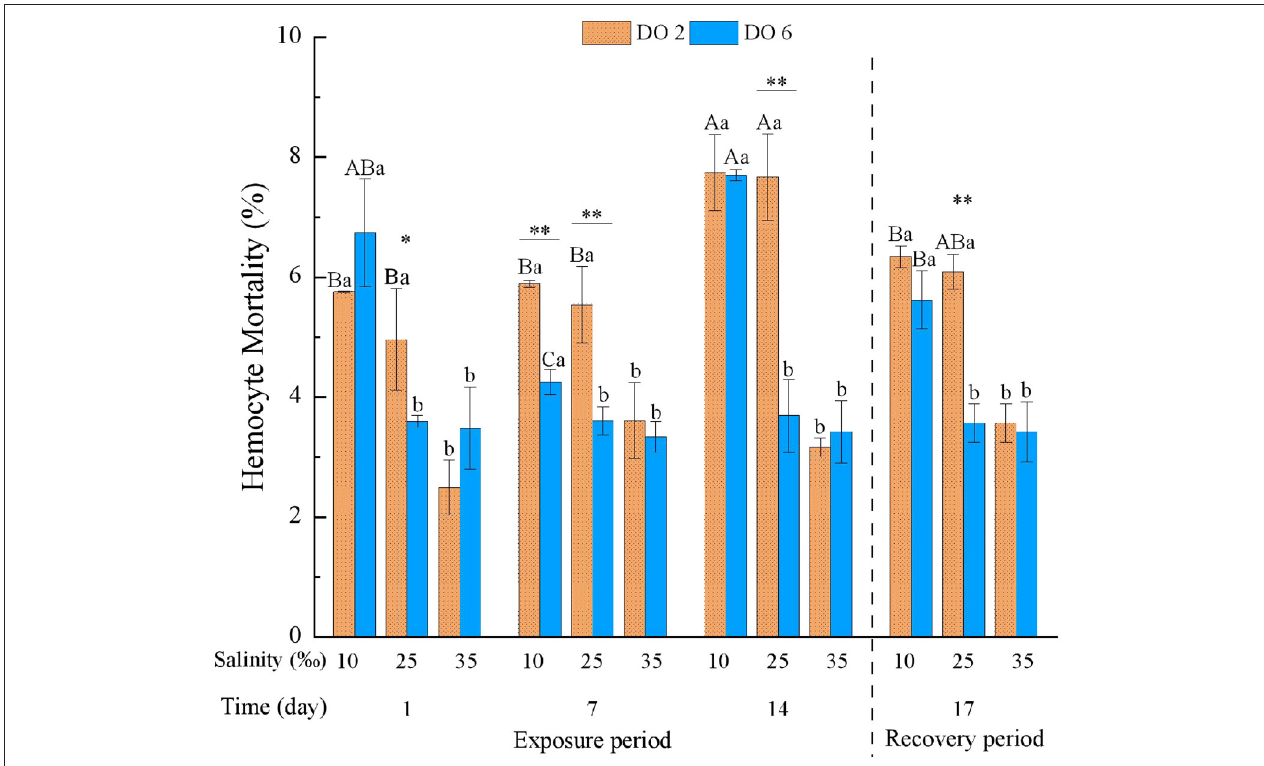
FIGURE 1 | Hemocyte mortality (HM) of Crassostrea hongkongensis exposed to six combinations of salinity (10, 25, and 35 ‰ ) and DO (2 and 6 mg/L) at 1, 7, and 14 days during the exposure period and 3 days for the recovery period. Different capital letters indicate significant differences among time points within each salinity level in hypoxia level (2 mg/L) or control group (6 mg/L) ( p < 0.05). Different small letters indicate significant differences between salinity within each time point in salinity level in hypoxia level (2 mg/L) or control group (6 mg/L) ( p < 0.05). Asterisk indicates significant differences between DO within each time point and fixed salinity treatment, in which * represents significant difference ( p < 0.05) and ** represents highly significant difference ( p < 0.01).